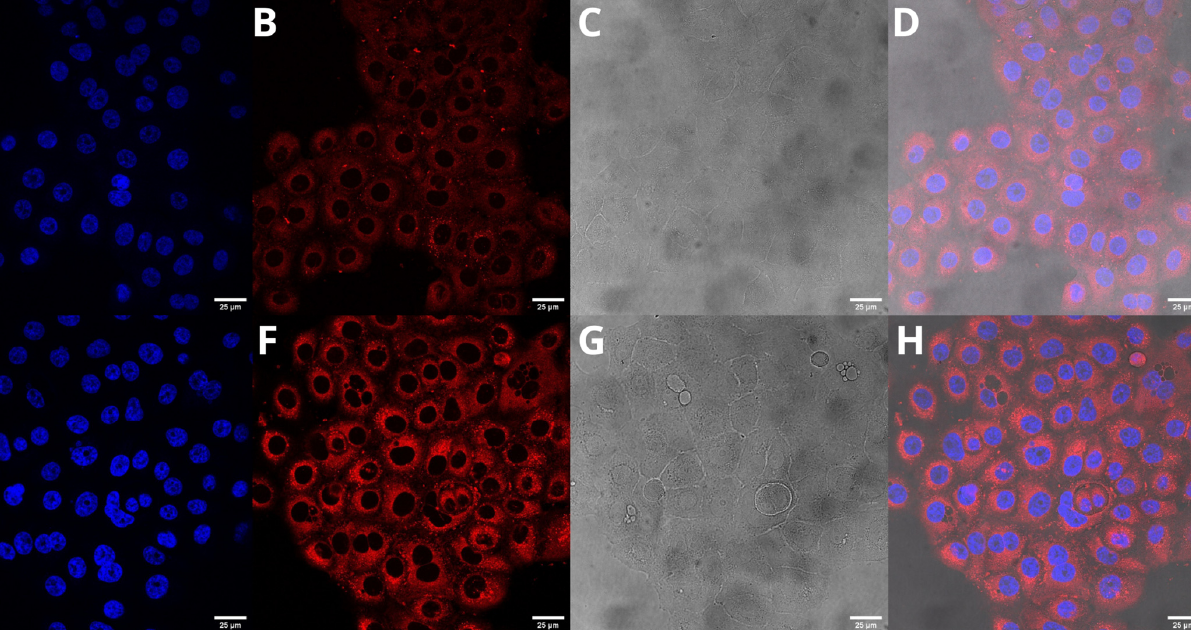
Figure 14. Visualization of the cellular uptake of Nile-Red-loaded UA-S85-PLGA-PEG 2000 nanoparticles by AsPC-1 pancreatic cell lines ( A , E ). DAPI ( B , F ). Nile Red fluorescence signal ( C , G ). Transmitted light ( D , H ). The merged image of the cells was observed after 15 ( A – D ) and 120 min ( E – H ) of incubation with the labeled particles. Scale bar = 25 µm.